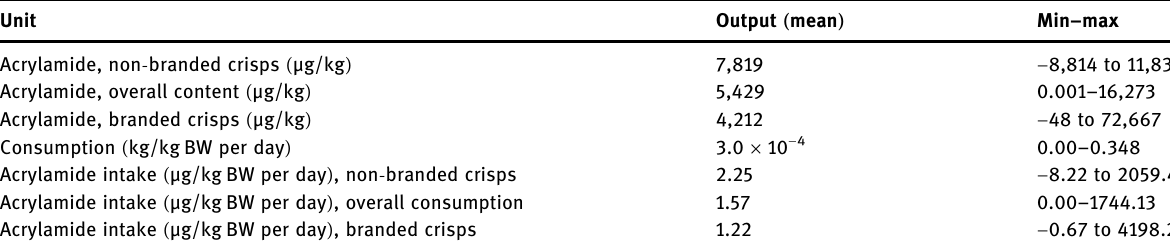
Table 2: Results of distribution fi tting and simulations of acrylamide intake in potato crisps Unit Output ( mean )